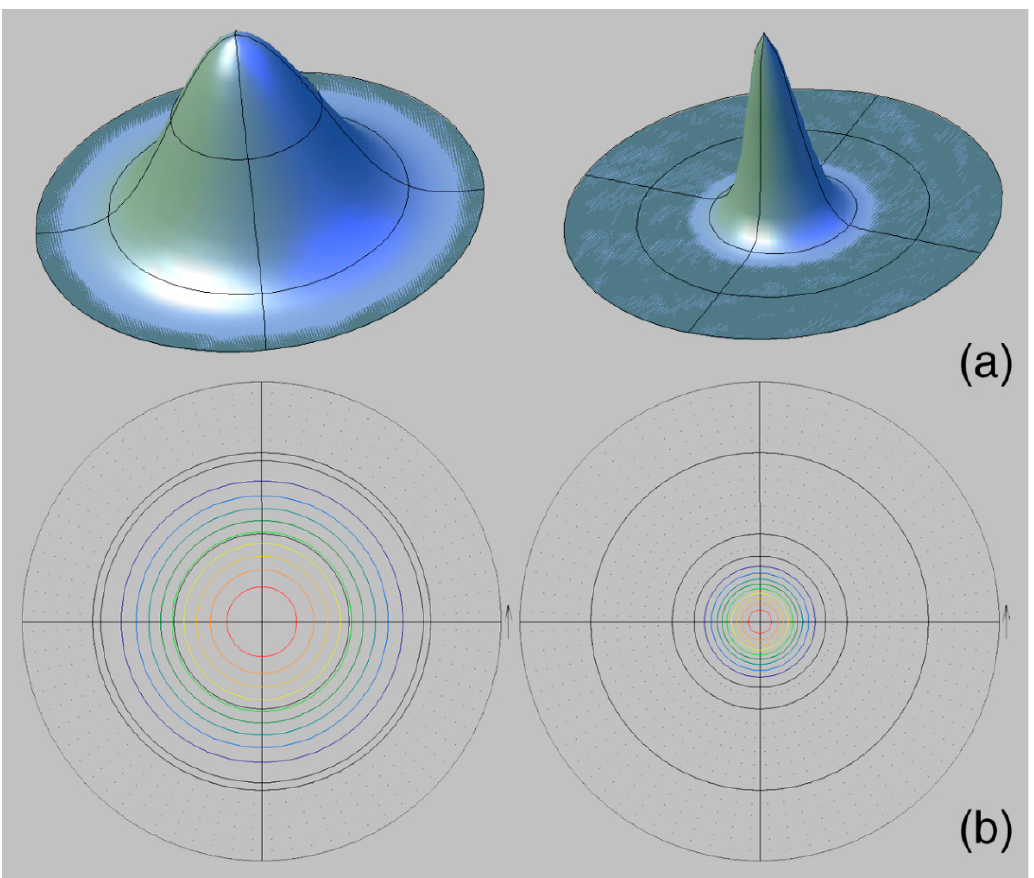
Figure 11. Models of crystal distribution peaks: ( a ) Illustration of the crystallographic texture sharpness; ( b ) its presentation on the pole figures. The circles with different color are isolines with the same pole density values.